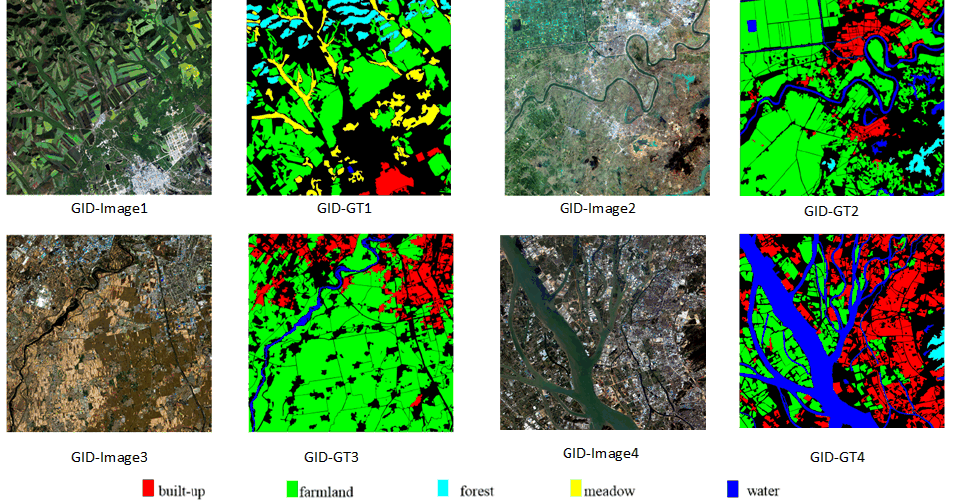
Figure 7. Experiment